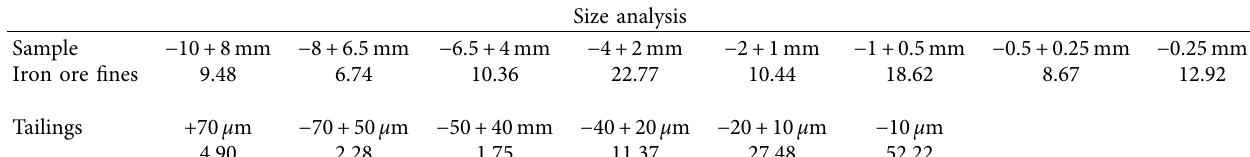
Table 1: Particle size distribution of feed.